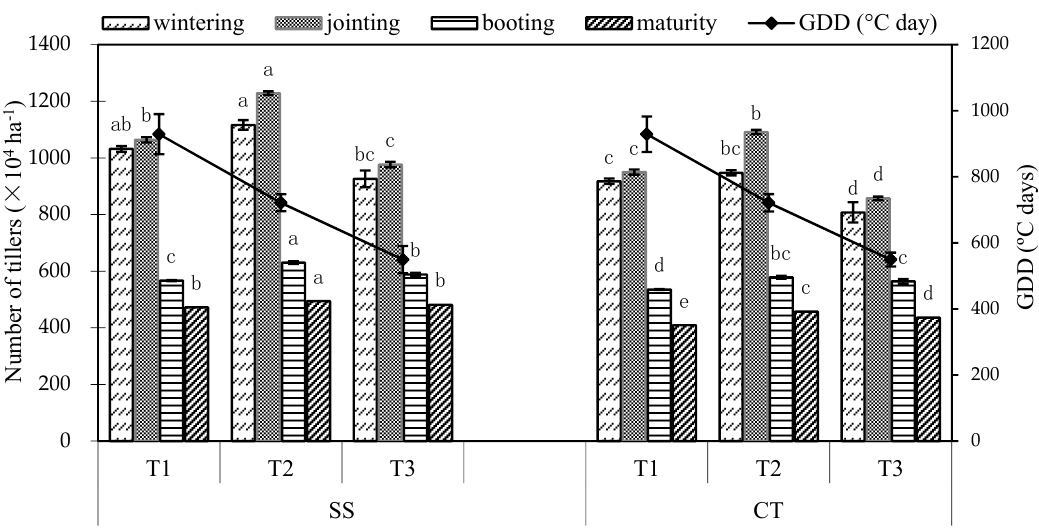
Figure 2. Effect of subsoiling and different sowing times on number of tillers (×10 4 ha − 1 ) and winter accumulated growing degree days (GDD) at different stages of winter wheat during 2013–2014. SS: Subsoiling during fallow period; CT: Conventional tillage; T 1 : Early sowing date; T 2 : Timely sowing; T 3 : Late sowing.